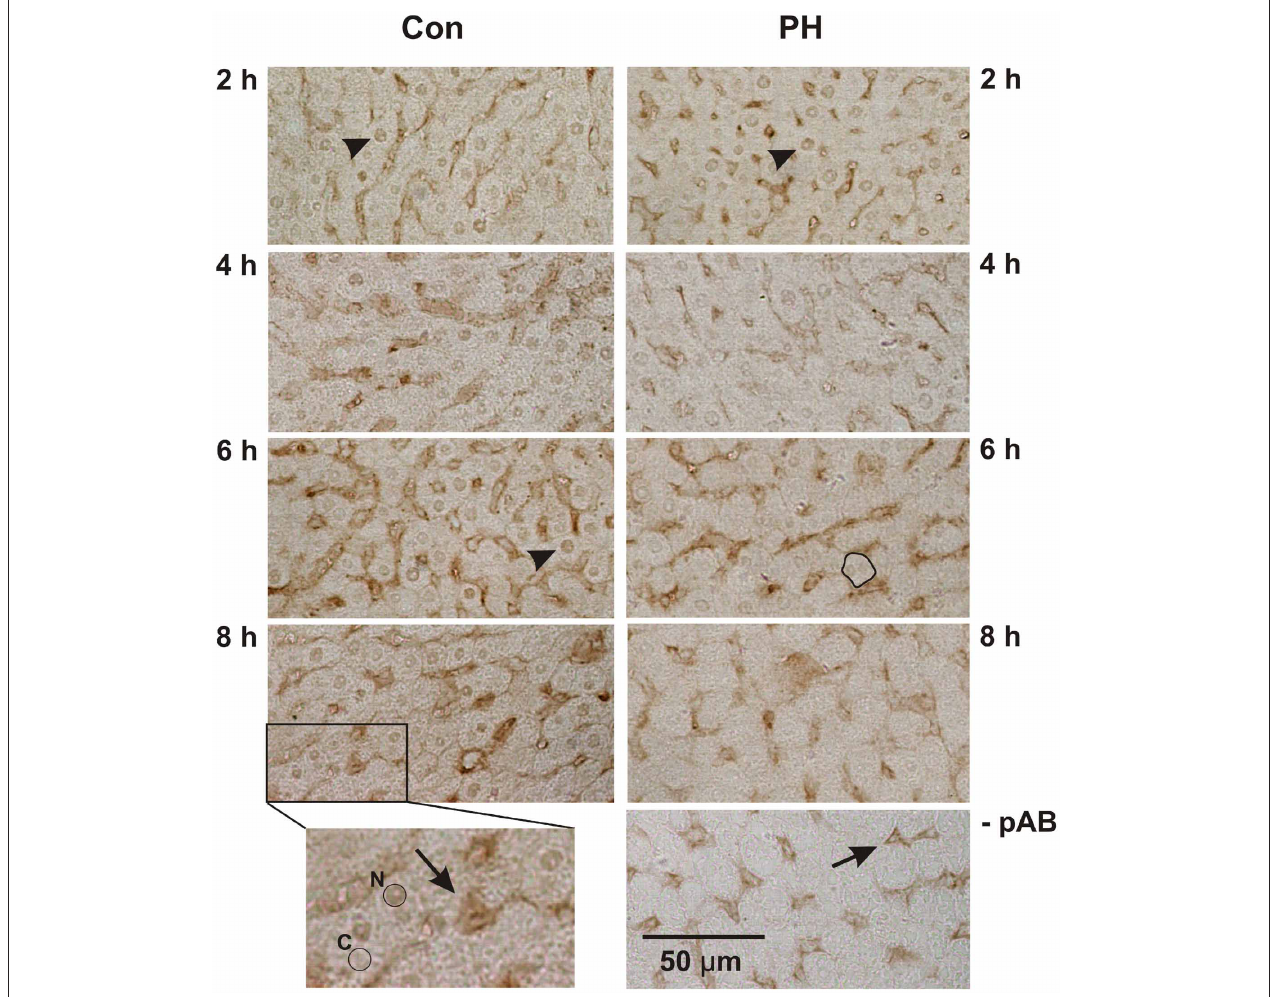
FIGURE 4 | Immune histochemical detection of p27Kip1 in paraffin sections of rat liver tissue obtained during or at different times after partial hepatectomy. Representative example images of control tissue (Con, obtained during the initial operation) and residual liver tissue at 2, 4, 6, or 8h after partial hepatectomy (PH), respectively, are shown. The image on the right at the bottom (-pAB) shows an example image developed without primary antibody which, in comparison with the control images on the left, shows lack of specific nuclear Kip1-staining, but retention of stain in the liver sinusoids (arrow) indicating that these signals are non-specific. Bottom left: enlarged area